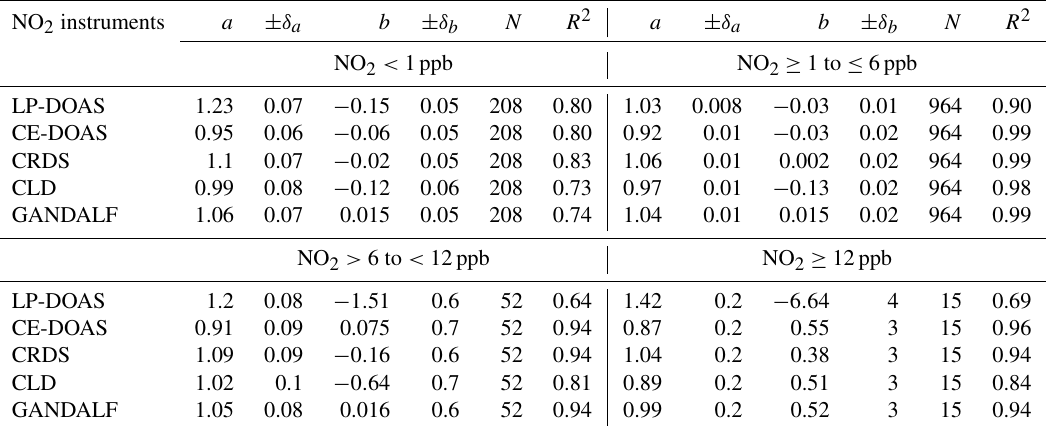
Table 3. Fit parameters based on the bivariate model function according to the relation (NO 2 instruments = a ×[ median NO 2 ]+ b ) at different NO 2 ranges. The value of NO 2 instrument intercept b is in ppb. N is number of data points and R 2 is the square correlation coefficient. ± δ is the standard error of slope a and intercept b